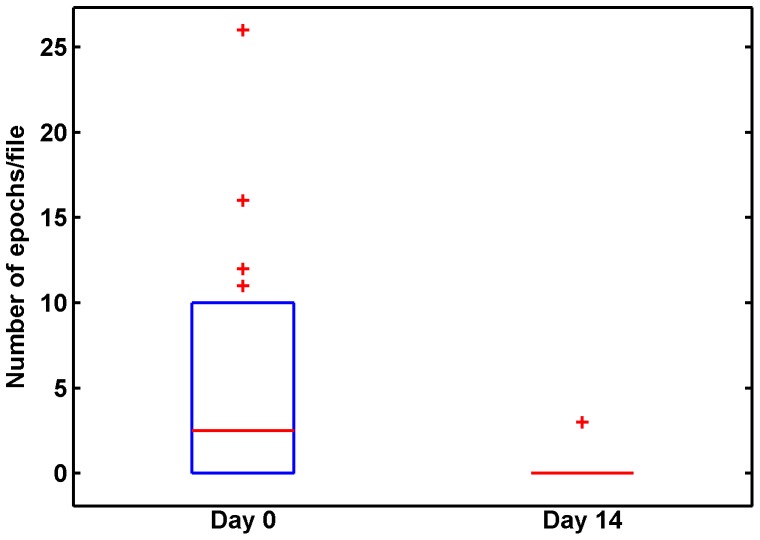
Boxplot comparing semi-automated estimate of cough count at day 0 and day 14.The plot shows 25th, 50th, and 75th percentiles, with outliers (1.5*IQR) are shown as ‘+’. At Day 14, the box collapses as 25th, 50th, and 75th percentiles are all zero.